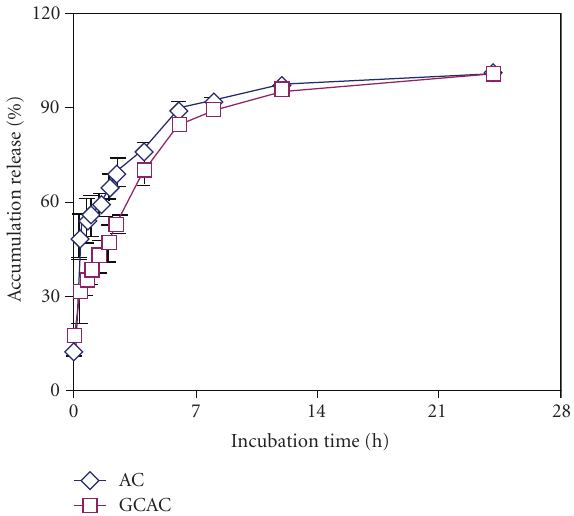
Figure 12: Cumulative release of encapsulated BSA from microcap- sules as a function of incubation time.